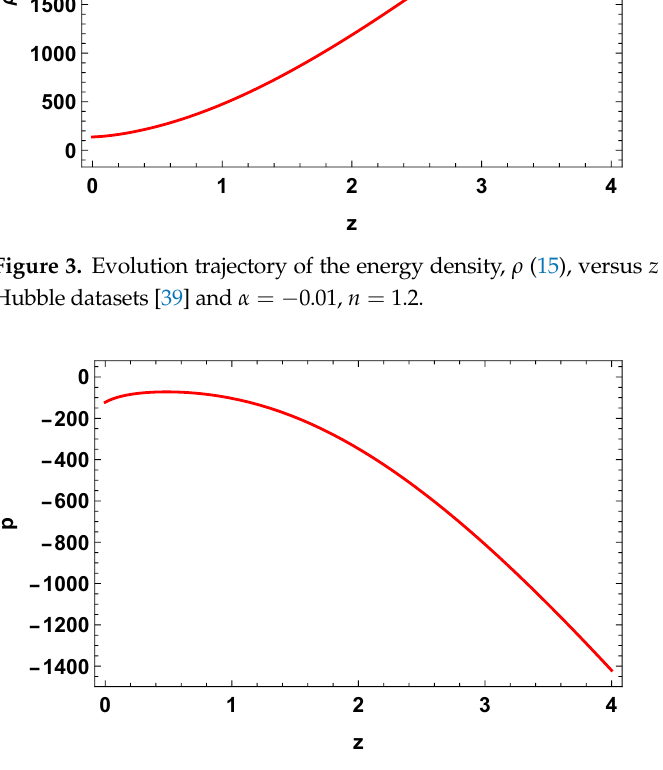
Figure 4. Evolution trajectory of the pressure, p (16), versus z with constraint values from the Hubble datasets [39] and α = − 0.01, n = 1.2.